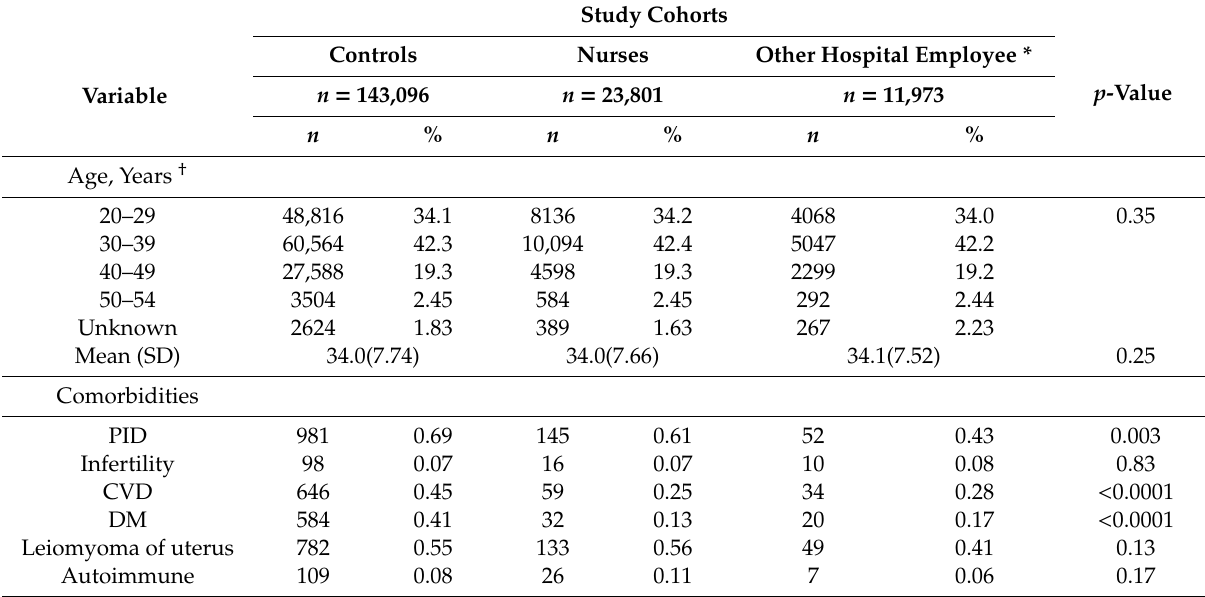
Table 1. Demographic characteristics and